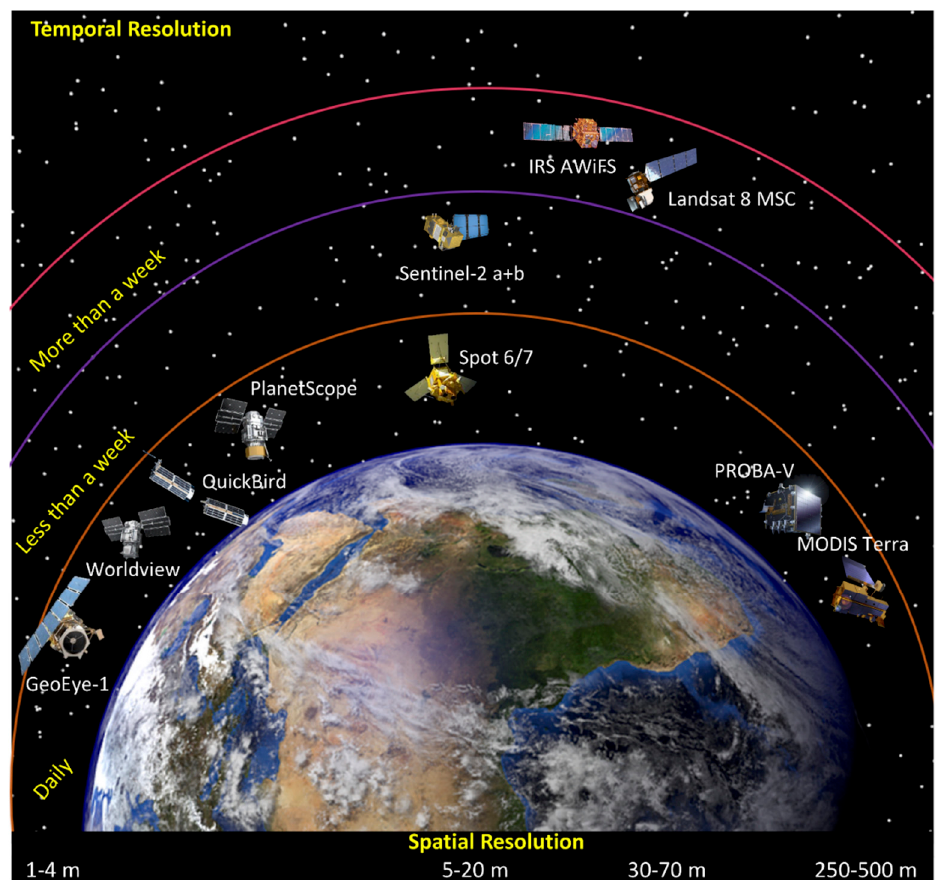
Figure 1. Current constellation of available satellites for land remote sensing that are highly relevant to crop monitoring and management, presented with their temporal and spatial resolution.